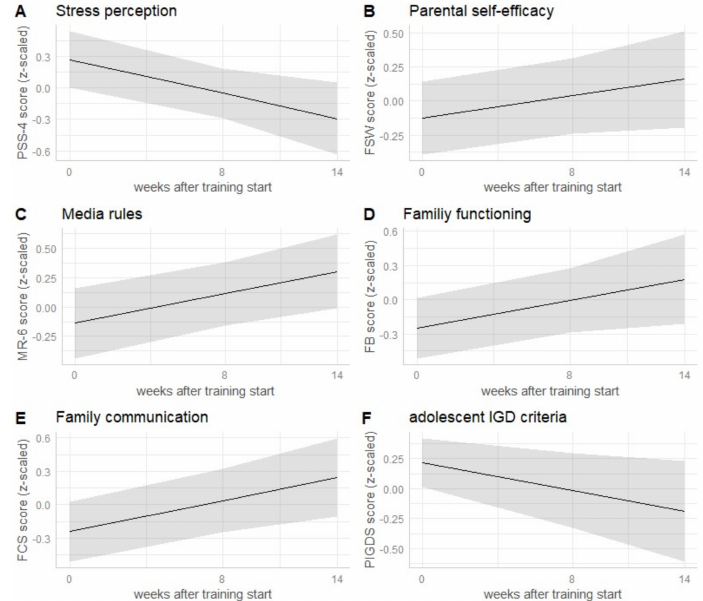
Figure 2. Latent growth models on six z-scaled criterion variables over weeks of study. Data were acquired before the start of the training (week 0), at the end of the training (week 8), and after a 6-week follow-up (week 14). Regression line is shown with a 95% CI. Notes: PSS-4 = Perceived Stress Scale (4-item version); FSW = Parental Self-Efficacy Questionnaire; MR-6 = Media Rules Questionnaire (6 items); FCS = Family Communication Scale; FB = Family Questionnaire ( Familienbogen-Kurzversion ); PIGDS = Parental Internet Gaming Disorder